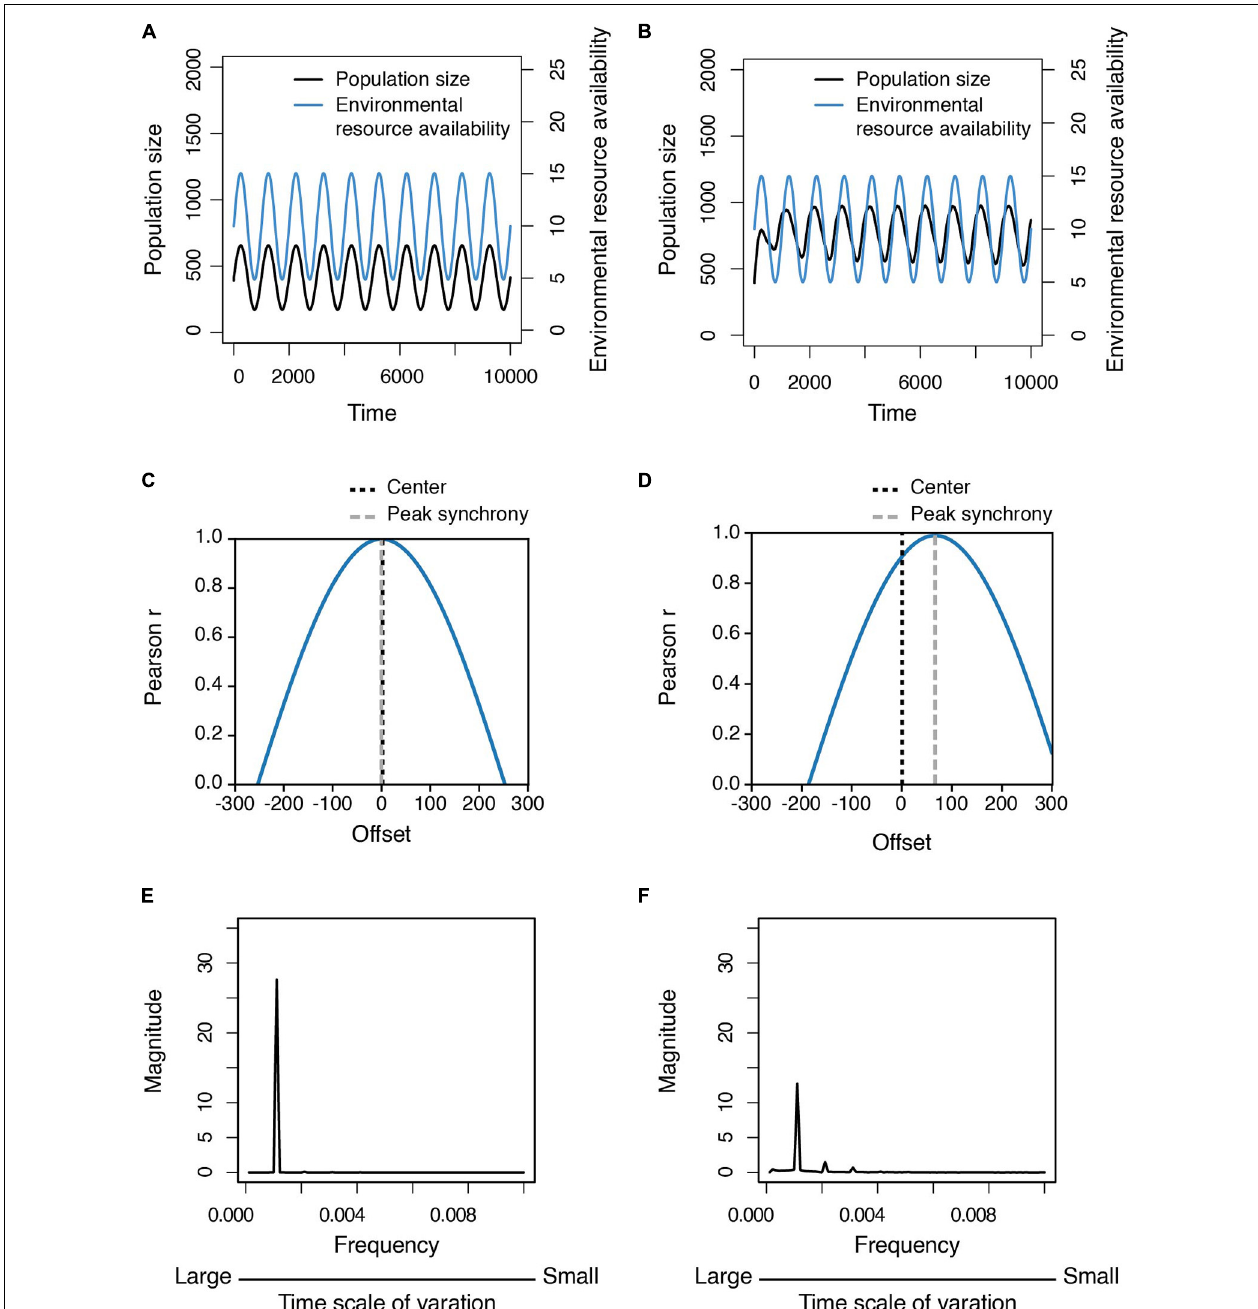
FIGURE 6 | Population dynamics and relative variability in population size in a fluctuating environment. (A,B) Time series of the population size of (A) non-social populations and (B) social populations in the fluctuating environment. (C,D) The time-lagged cross correlation between the population dynamics and the environmental fluctuation for (C) non-social populations and (D) social populations. (E,F) The frequency spectra of the population size variation standardized by mean, which are derived from fast Fourier transformation, are shown for (E) non-social populations and (F) social populations. Each line is the average of the output data of 500